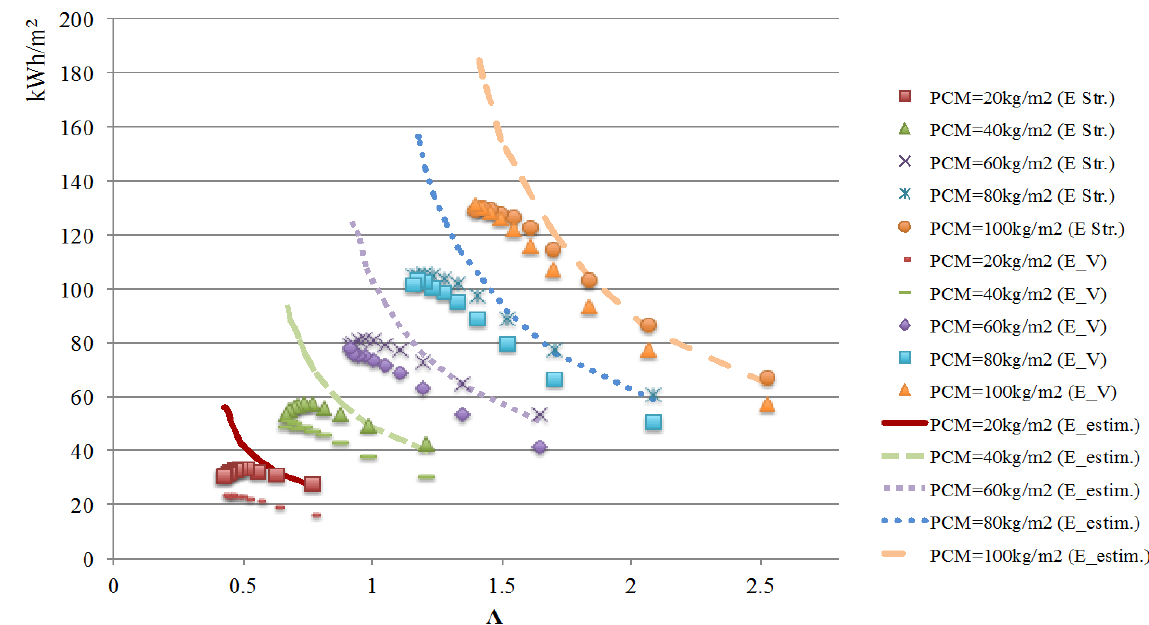
Figure 11. Energy stored, energy delivered for ventilation, and estimated energy storage in July and August.